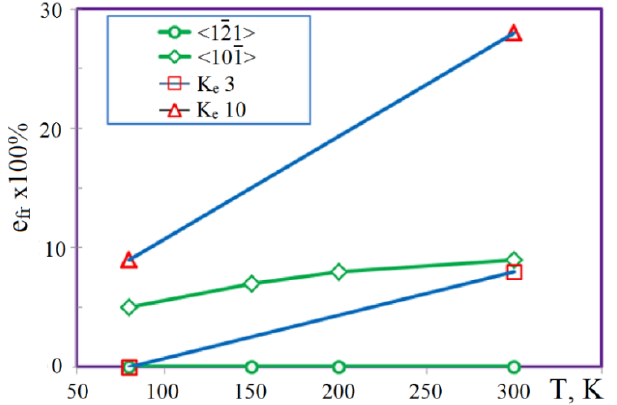
Figure 9. Elongation-to-fracture of single crystals ( F b || <10 1̅ > or <1 2̅ 1>) and extruded samples de- pending on temperature and extrusion ratio K e